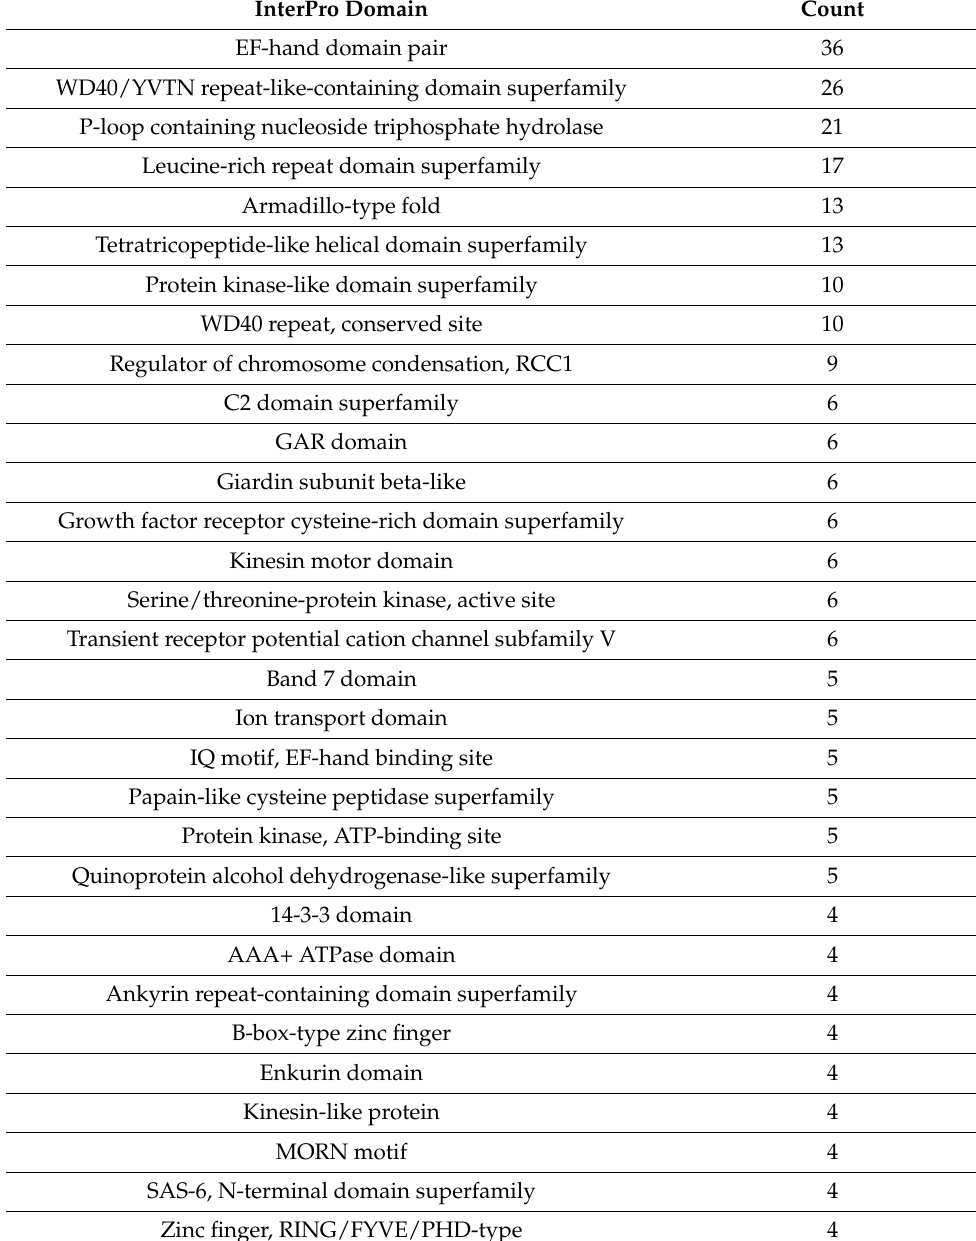
Table 1. InterPro domains found in MIC-enriched proteins . Domains that were found in at least four proteins are listed, with redundant domain entries removed. The complete list is provided in Supplementary Table